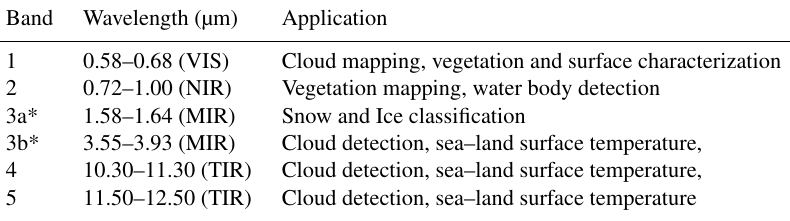
Table 1. Spectral characteristics of AVHRR sensors.